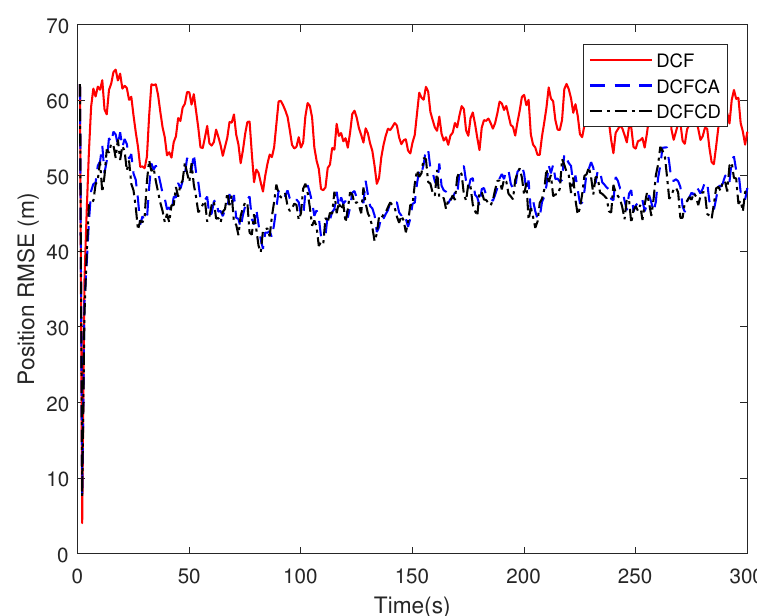
Figure 9. The position RMSE for different consensus filters of failure node.